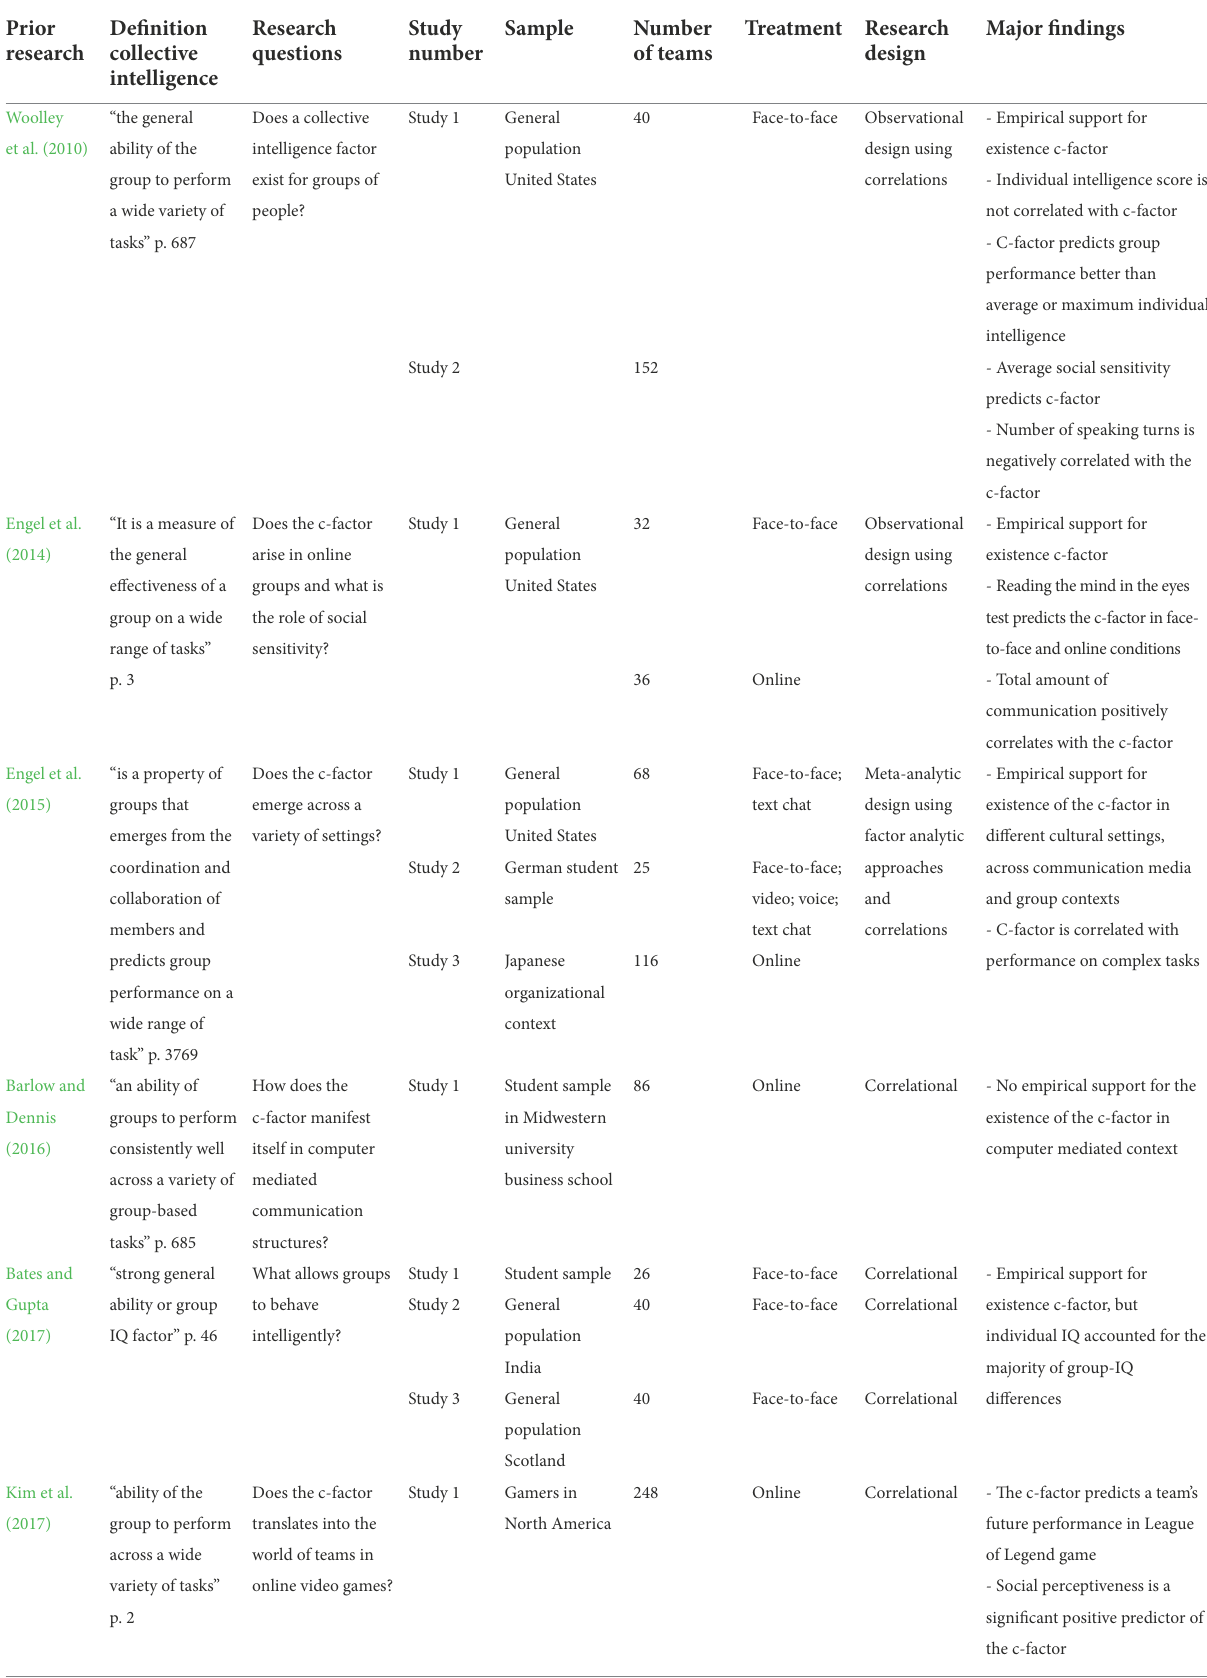
TABLE 1 Representative sample of the collective intelligence factor research stream. Prior